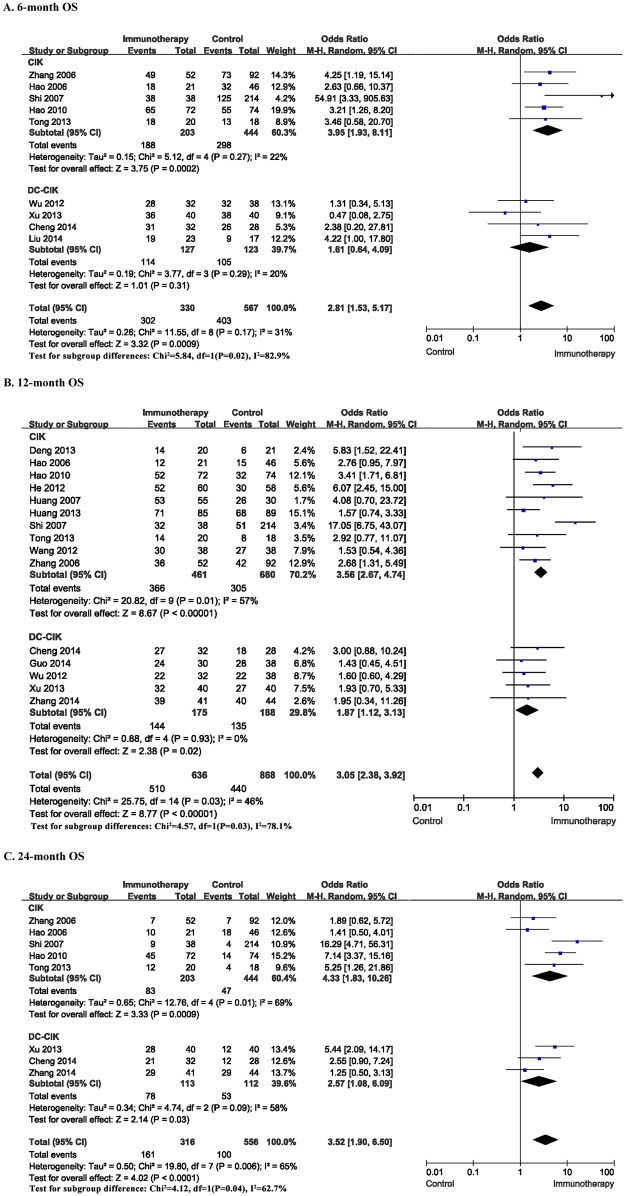
Comparison of 6, 12, 24-month OS between the patients undergoing cellular immunotherapy or not.The random effects model (Mantel-Haenszel method) was used.